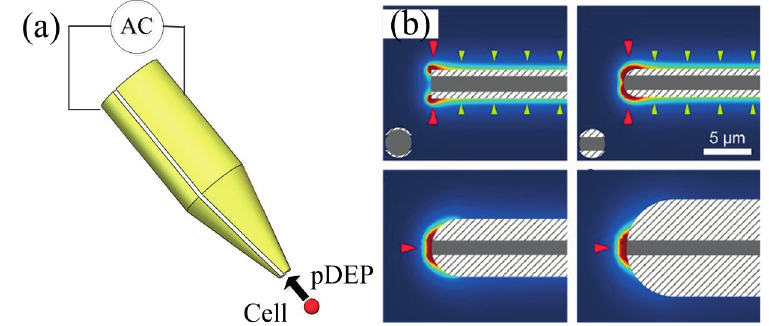
Figure 3. DEP tweezers. ( a ) Schematic diagram of DEP tweezers designed by Hunt TP; ( b ) the electric field strength simulation